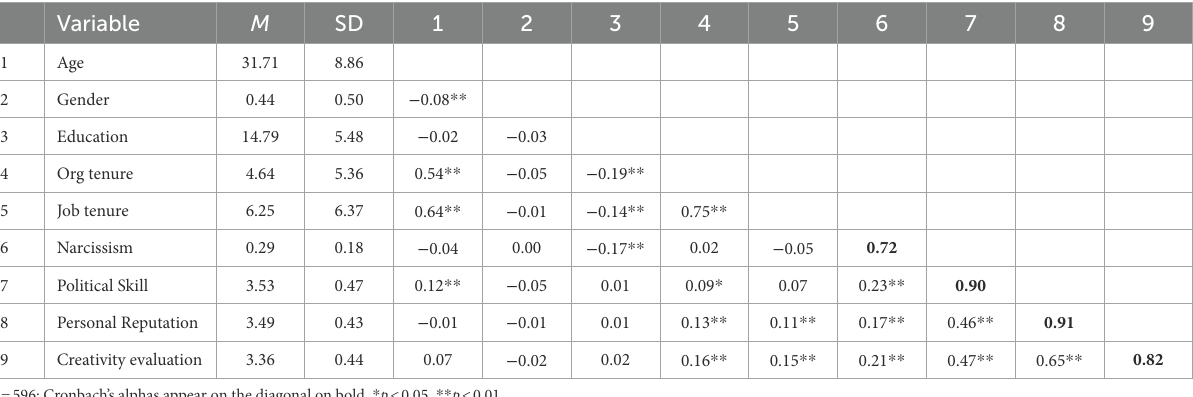
TABLE 1 Descriptive statistics, reliability coefficients, and correlations.